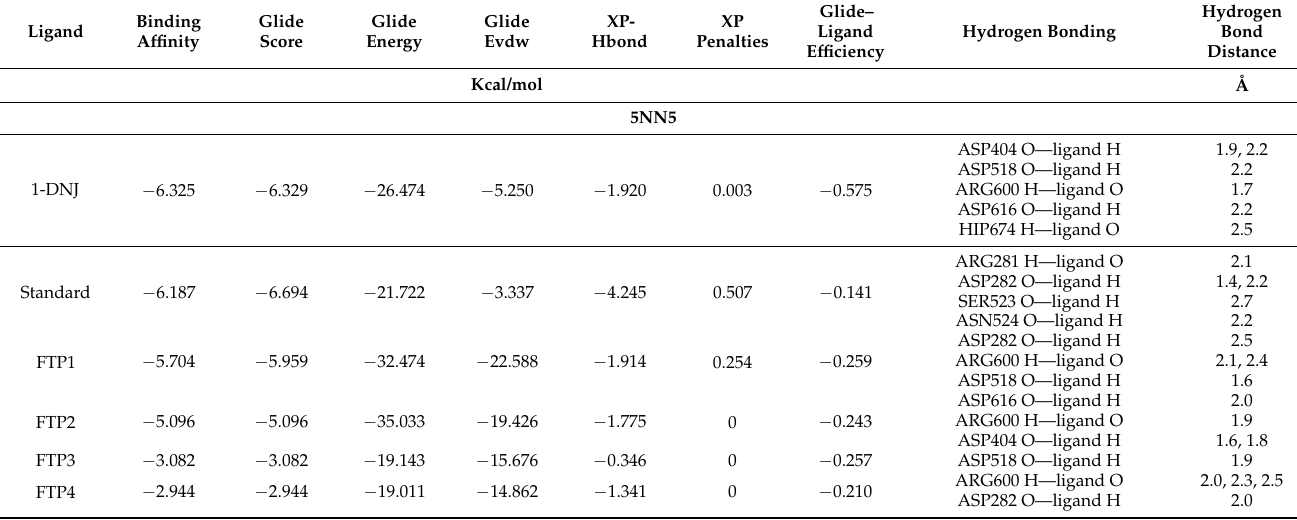
Table 4. Molecular docking analysis of phenolic compounds of Tradescantia pallida